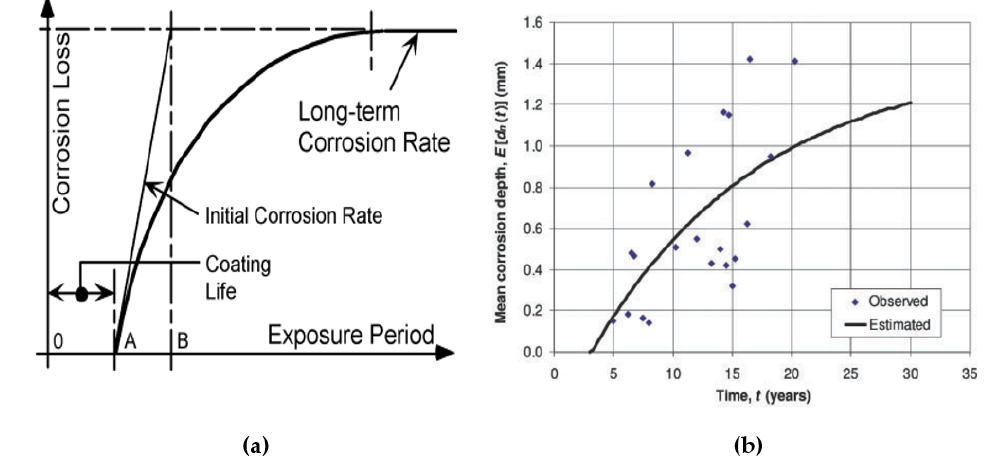
Figure 2. Corrosion degradation model of Guedes Soares and Garbatov [10] ( a ) with fitted data of the bottom plating of the bulk carriers [14] ( b